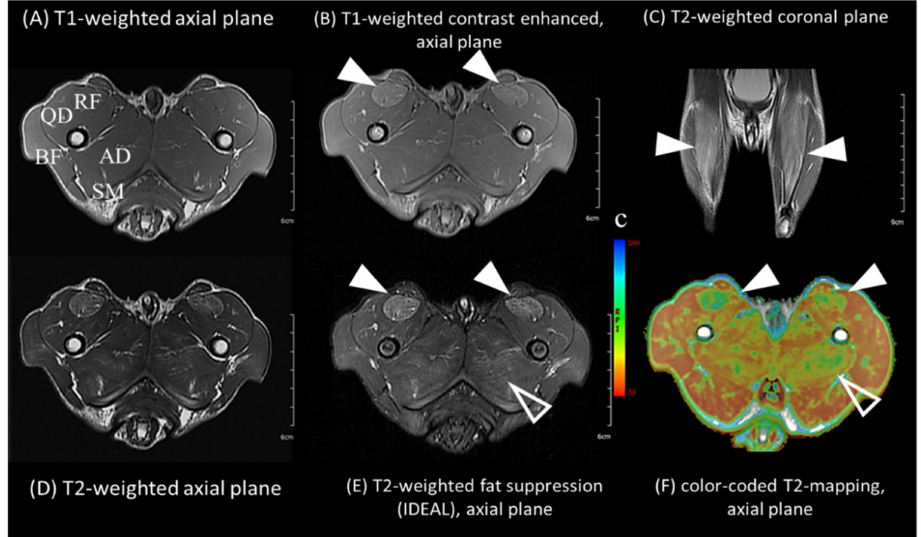
Figure 2. Magnetic resonance imaging of the dystrophin mutant dog. Rectus femoris (RF, arrow- heads) and adductor magnus (AD, open arrowheads) muscles show marked hyperintense, contrast- enhancing lesions with minimal fatty replacement. On T1-weighted image ( A , B ), quadriceps muscles (QD) are moderately atrophied. Note diffuse lesions are found in anterior-medial hindlimb muscles with low T2 values (green color) on ( F ). Posterior-lateral hindlimb muscles, including biceps femoris (BF), semitendinosus (ST), and semimembranosus (SM) muscles, tend to be relatively